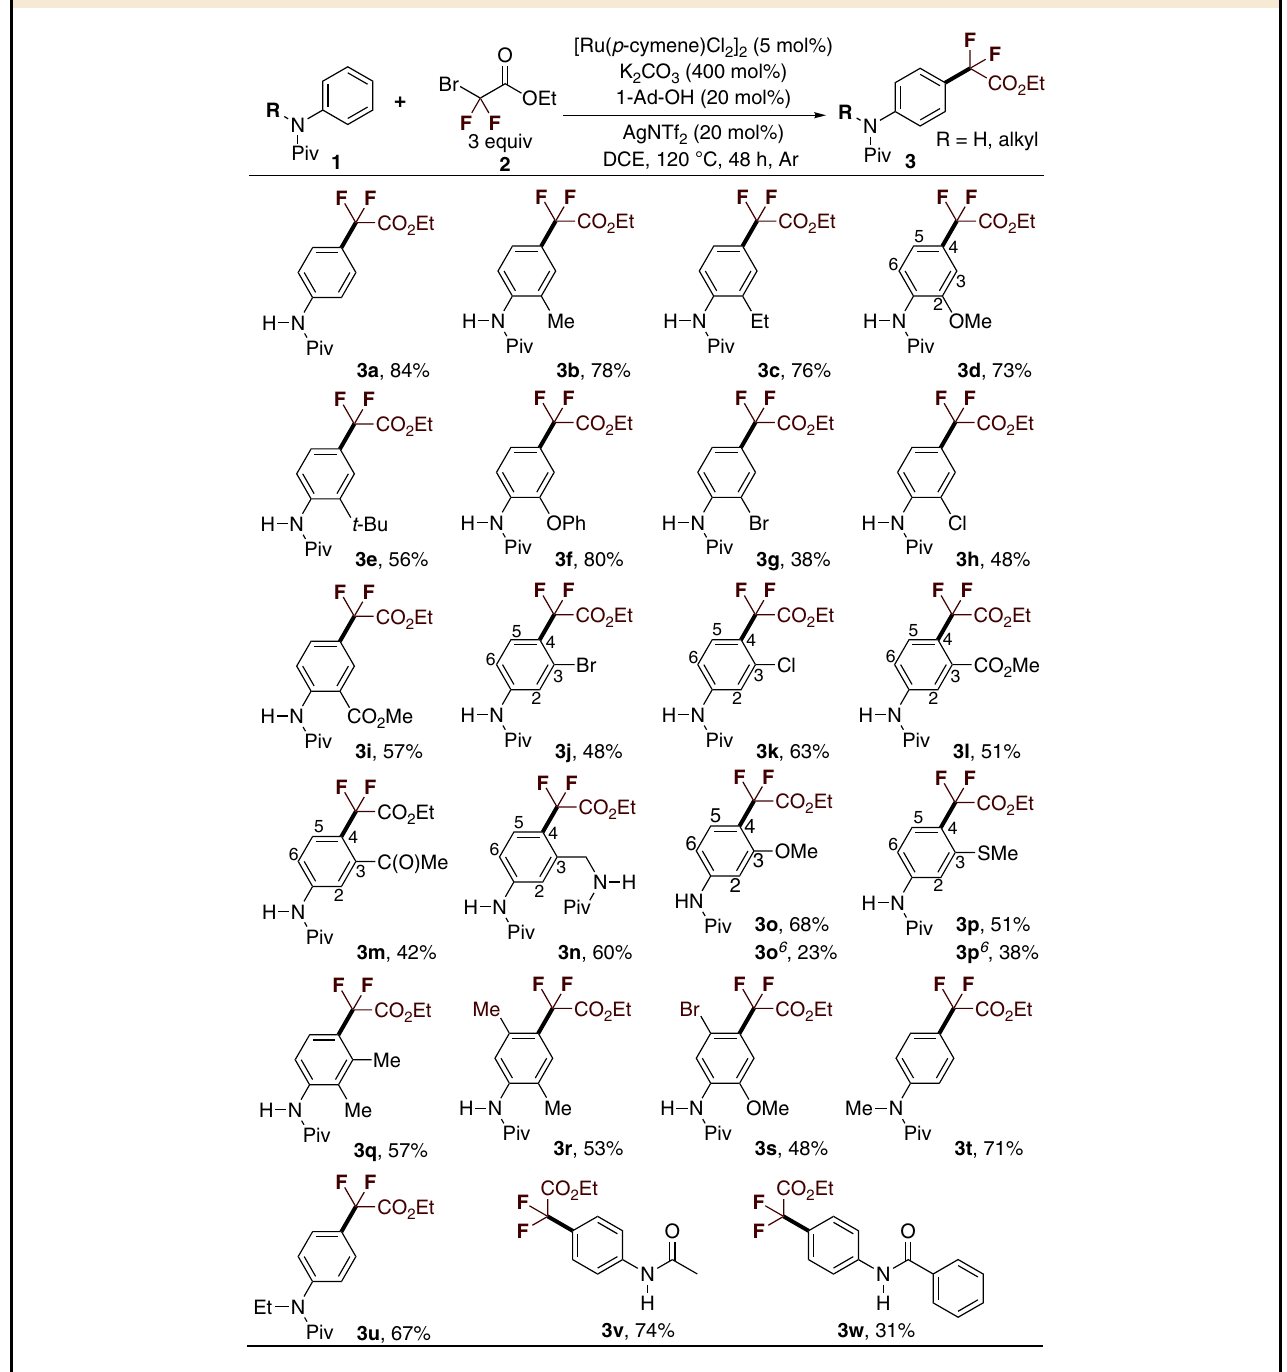
ruthenium-enabled di fl uoromethylation selectively occurs at the para position. In addition, we extended the reaction to mono- fl uoromethylation and non- fl uoromethylation, but we obtained only <20% yields of the corresponding products under harsh reaction conditions (Fig. 2). This result may be attributed to the stability of the corresponding free radicals.